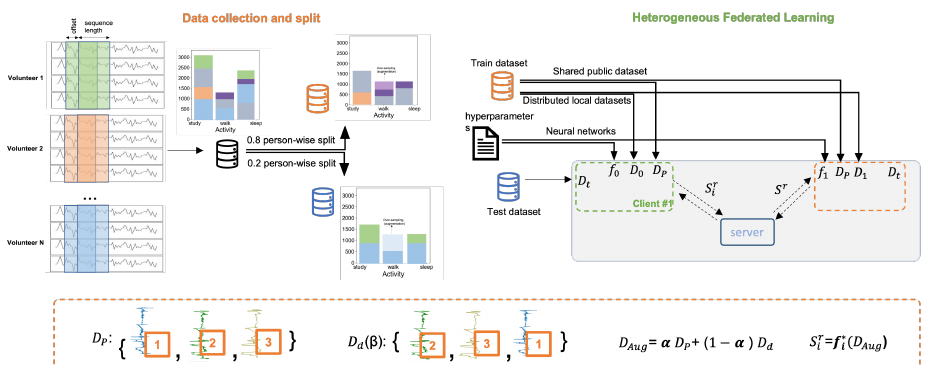
Figure 4. An overview of data preprocessing and splitting of the self-collected HARB dataset, and how each component is being utilized in the proposed heterogeneous Federated Learning system. The dotted box in the bottom explains the augmentation mechanism used in this work which is based on mixup augmentation and permutation. Signal colors and the associated number represent the index of each sample.